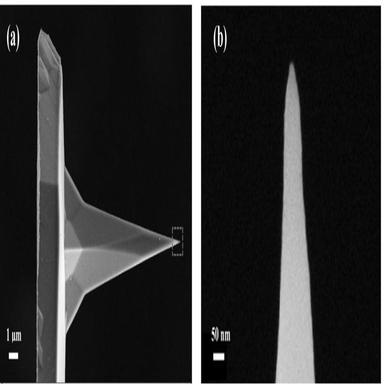
Low- (a) and high-magnification (b) FESEM images of NSG10 probe.